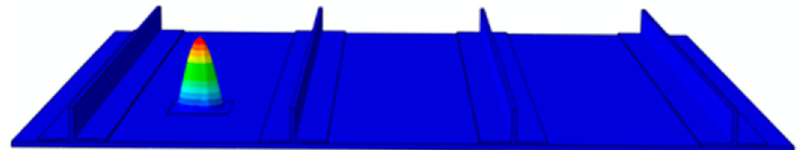
Figure 7. Deformed shape of linear buckling analysis for the stiffened panel with delamination size A .